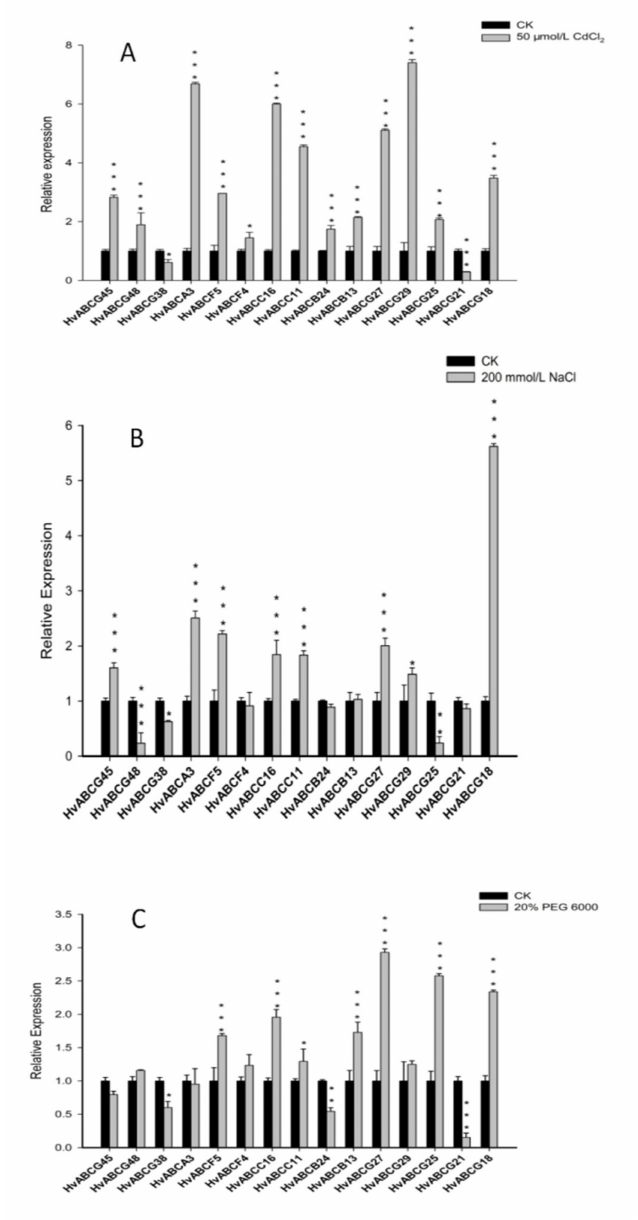
Figure 5. qRT-PCR analysis of 15 HvABC genes in response to ( A ) 50 µ mol · L − 1 CdCl 2 ( B ) 200 mmol · L − 1 NaCl ( C ) 20% PEG6000. columns in black represent CK, columns in gray represent abiotic stress. ANOVA and LSD was used to test significance. Asterisks indicate the corresponding gene significantly up- or down-regulated compared with the untreated control (* p < 0.05, ** p < 0.01, *** p < 0.001) Data are the means of three replicates with standard errors represented by